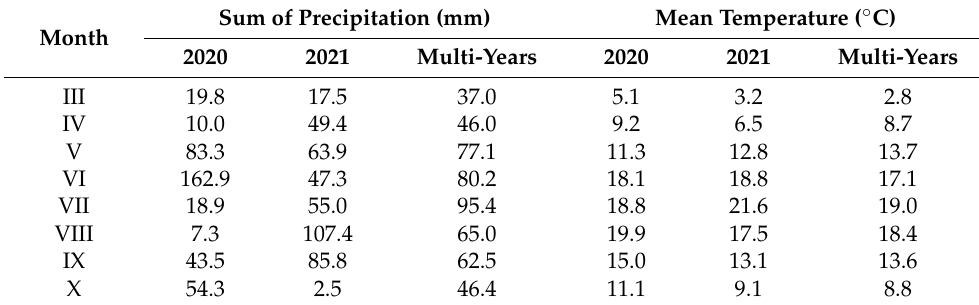
Figure 1. Plant height (cm). A–F—variants of fertilization. Different lowercase letters indicate significant differences ( p < 0.05) according to the analysis of variance (ANOVA). Table 3. Weather conditions .